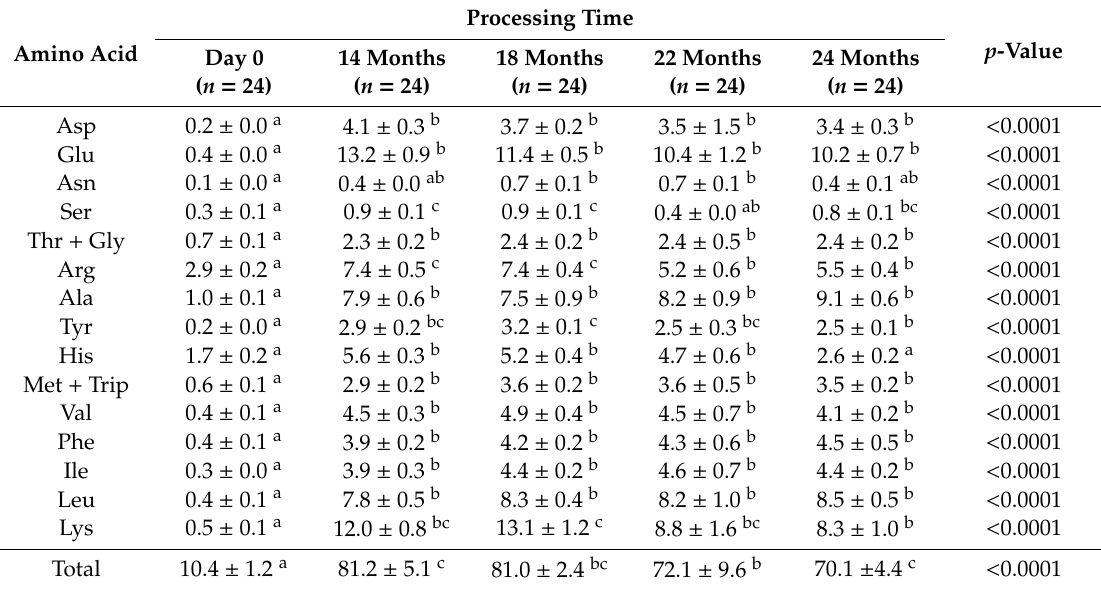
Table 5. E ff ect of processing time on free amino acids in Chato murciano dry-cured ham. Results are expressed as g / Kg of total solids (means values ±